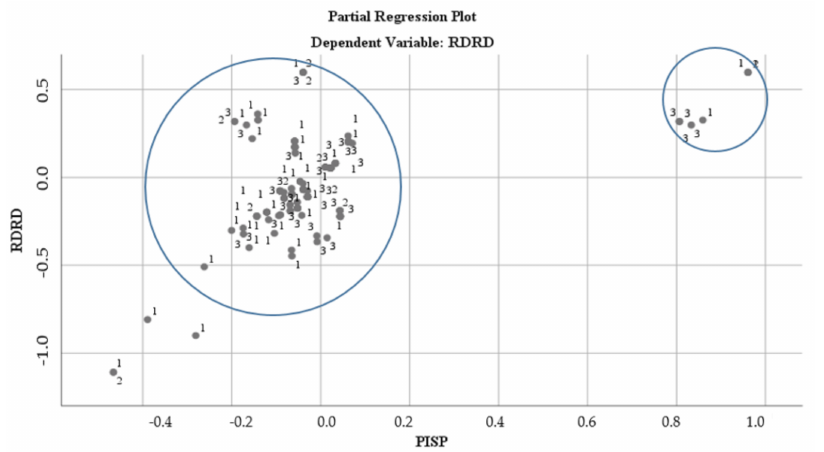
Figure 13. Regression analysis for